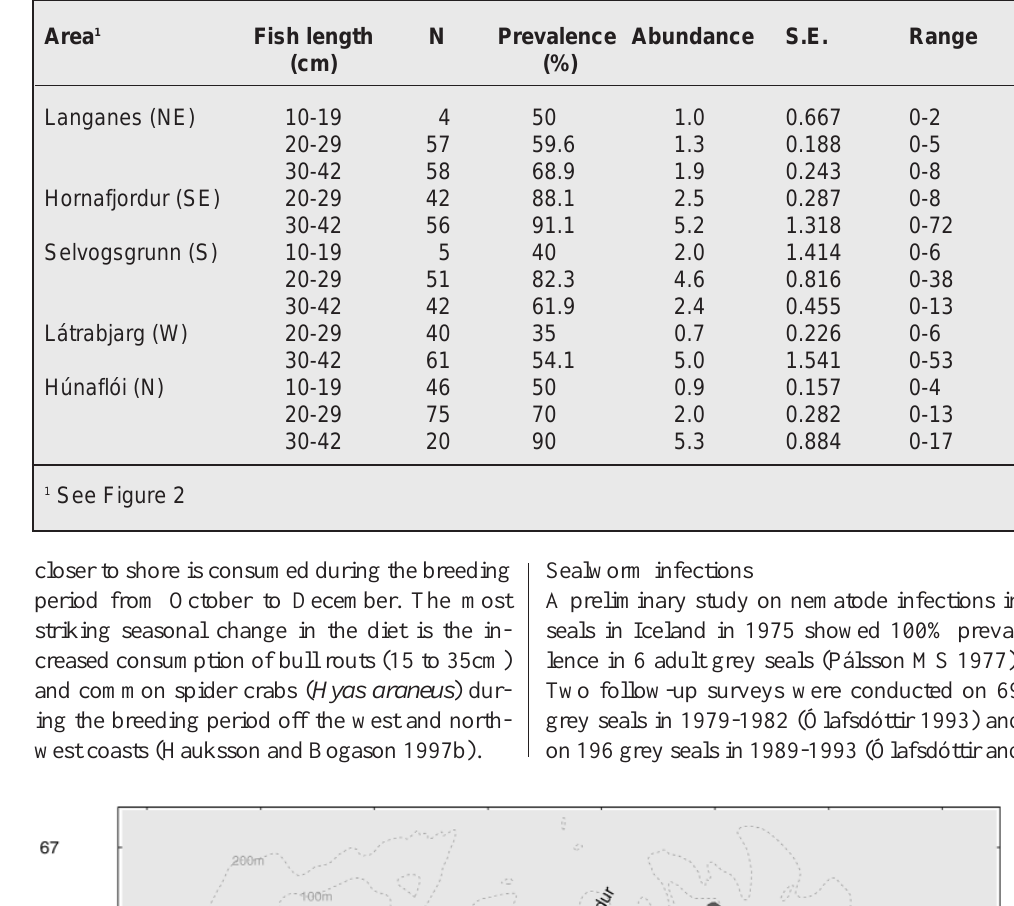
Table 2 . Prevalence and abundance of sealworm ( Pseudoterranova decipiens ) in long rough dab ( Hippoglossoides platessoides ) of different length classes at various locations in shallow waters around Iceland in 1980-91 .